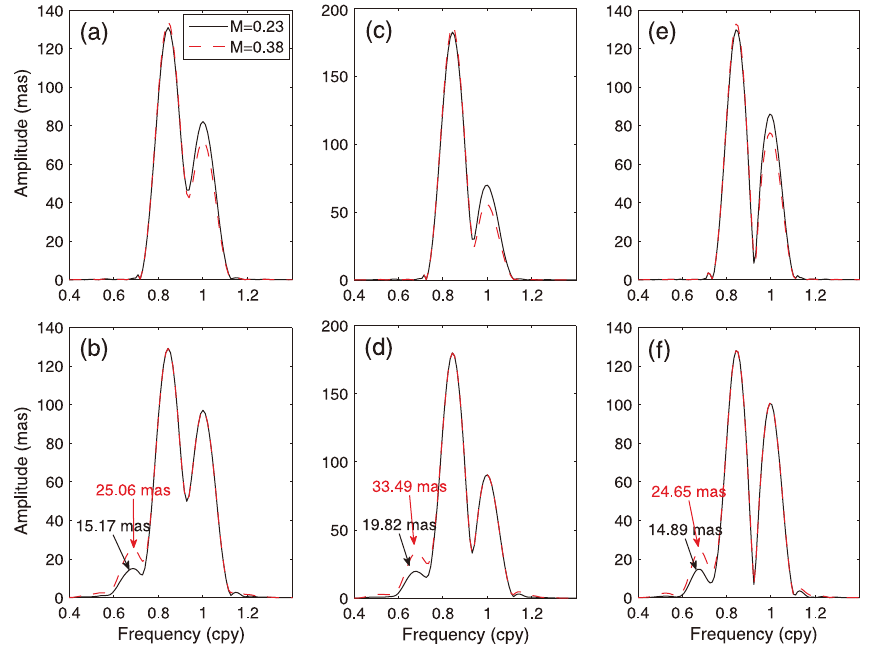
Figure 6. The amplitude spectra of the synthetic records (noise-free) based on a conventional approach (a–f) for the x -component of the 1962–1977 series, 1978–1994 series, and 1995–2013 series, respectively. The three top figures show the results without considering the frequency modulation of CW, whereas the three bottom figures are the corresponding results considering the frequency modulation of CW, with the modulation index M = 0 . 23 (black curves) and 0.38 (red dashed curves). Table 4. The input parameters for the six synthetic series. (FM: frequency